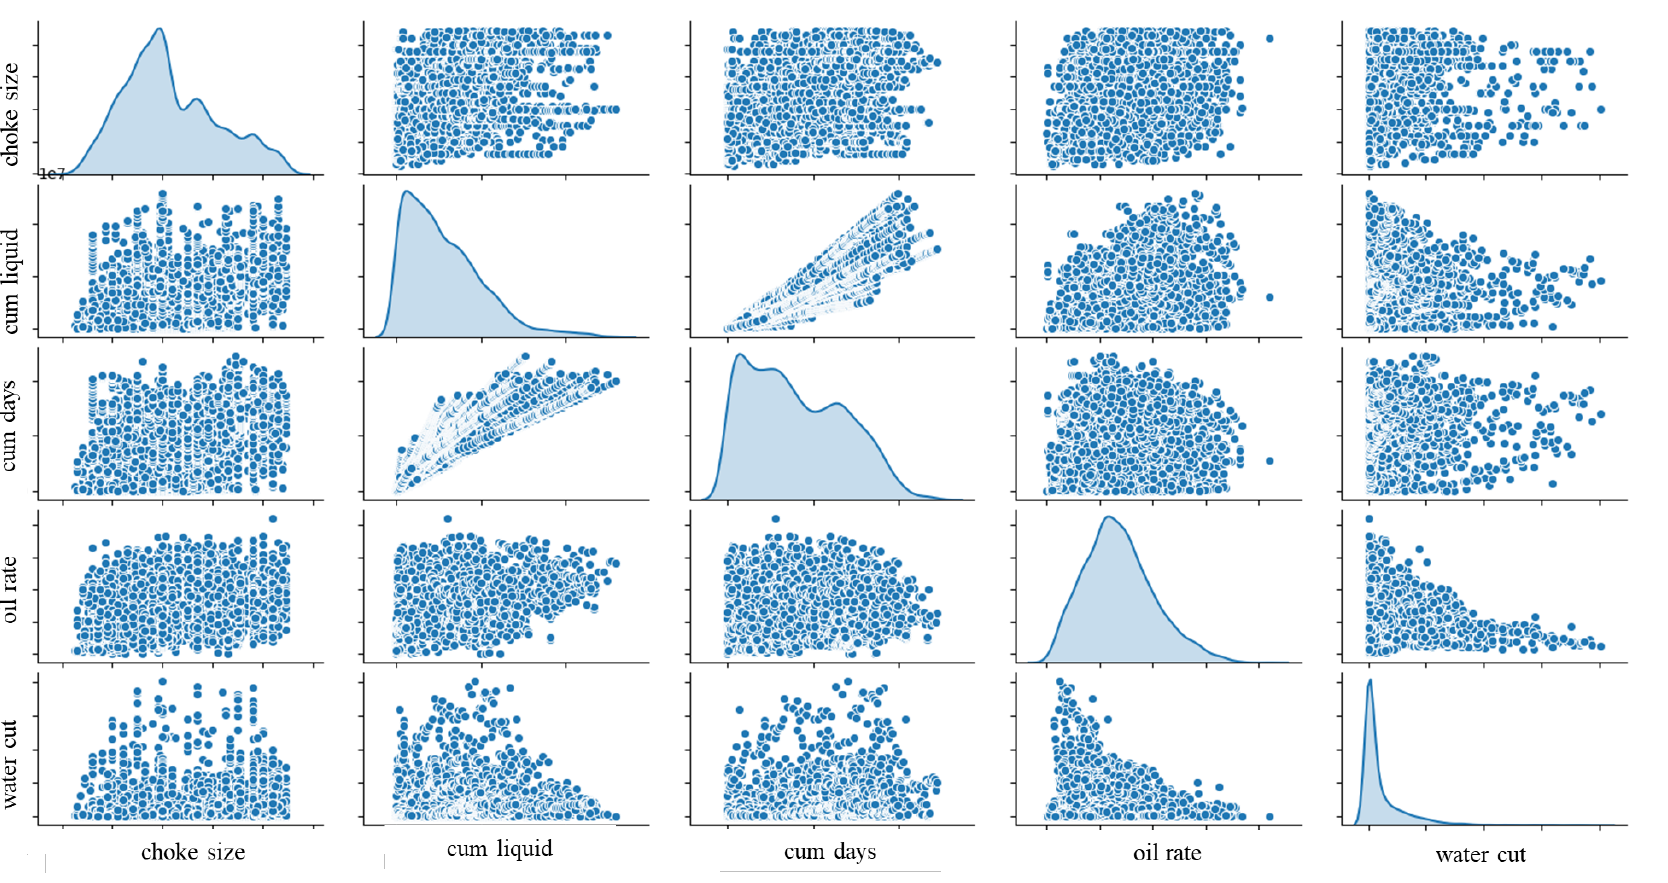
Figure 6. Joint distribution of a few pairs of extracted features.